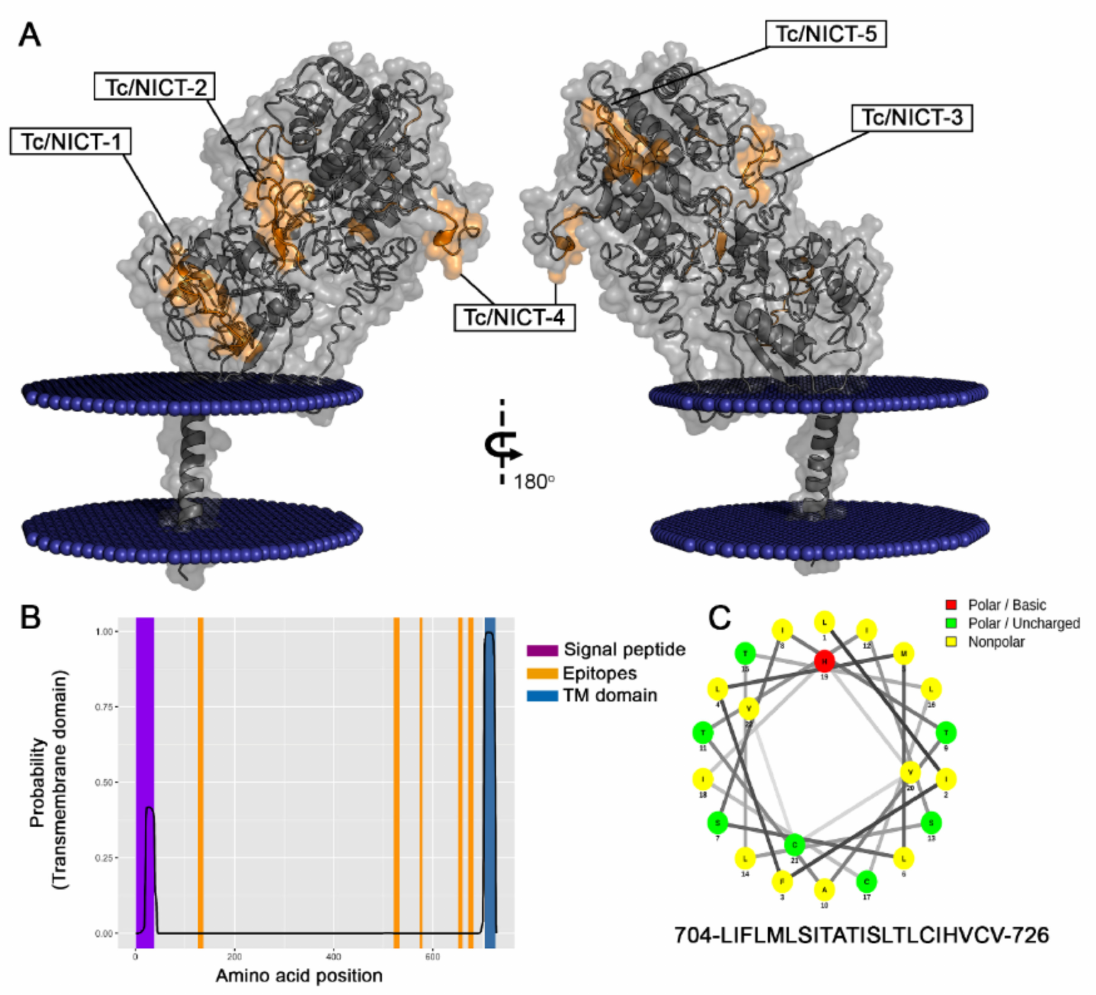
Figure 5. Model of Tc-NICT with amino acid and transmembrane domain analysis. ( A ) Putative membrane-spanning model of Trypanosoma cruzi NICT with the TM domain (aa 704–aa 726), a large extracellular domain, and a site of membrane interaction with embedded residues (aa 48–54, aa 58) determined using the I-Tasser approach Orientation Membrane Protein access (https://opm.phar.umich.edu/, accessed on 1 October 2020). The five linear B epitopes (Orange) identified by Spot-synthesis are shown. ( B ) Hydropathy plot showing the TM probability (blue) of NICT amino acid sequences along with the signal sequence (purple) and epitopes (orange). ( C ) Helical wheel analysis of TM domain showing the amino acid composition of an alpha